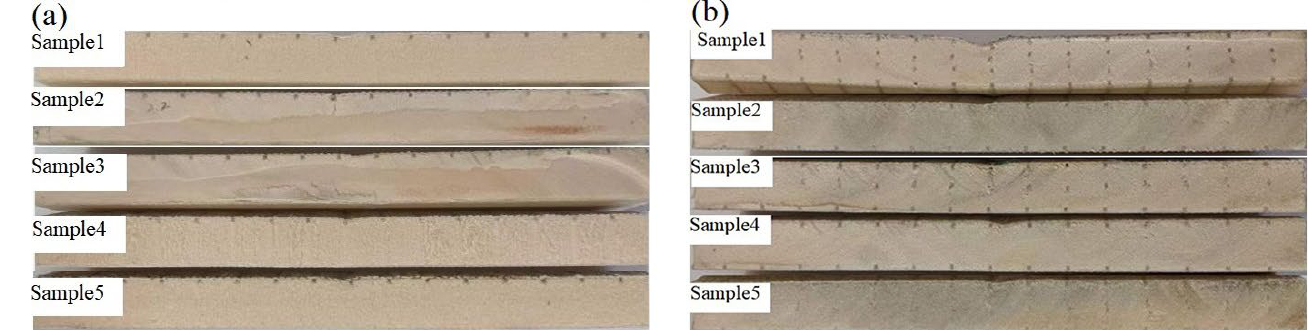
Figure 24. Side images of the crack failures of samples ( a ) and ( b ) during the bending test.